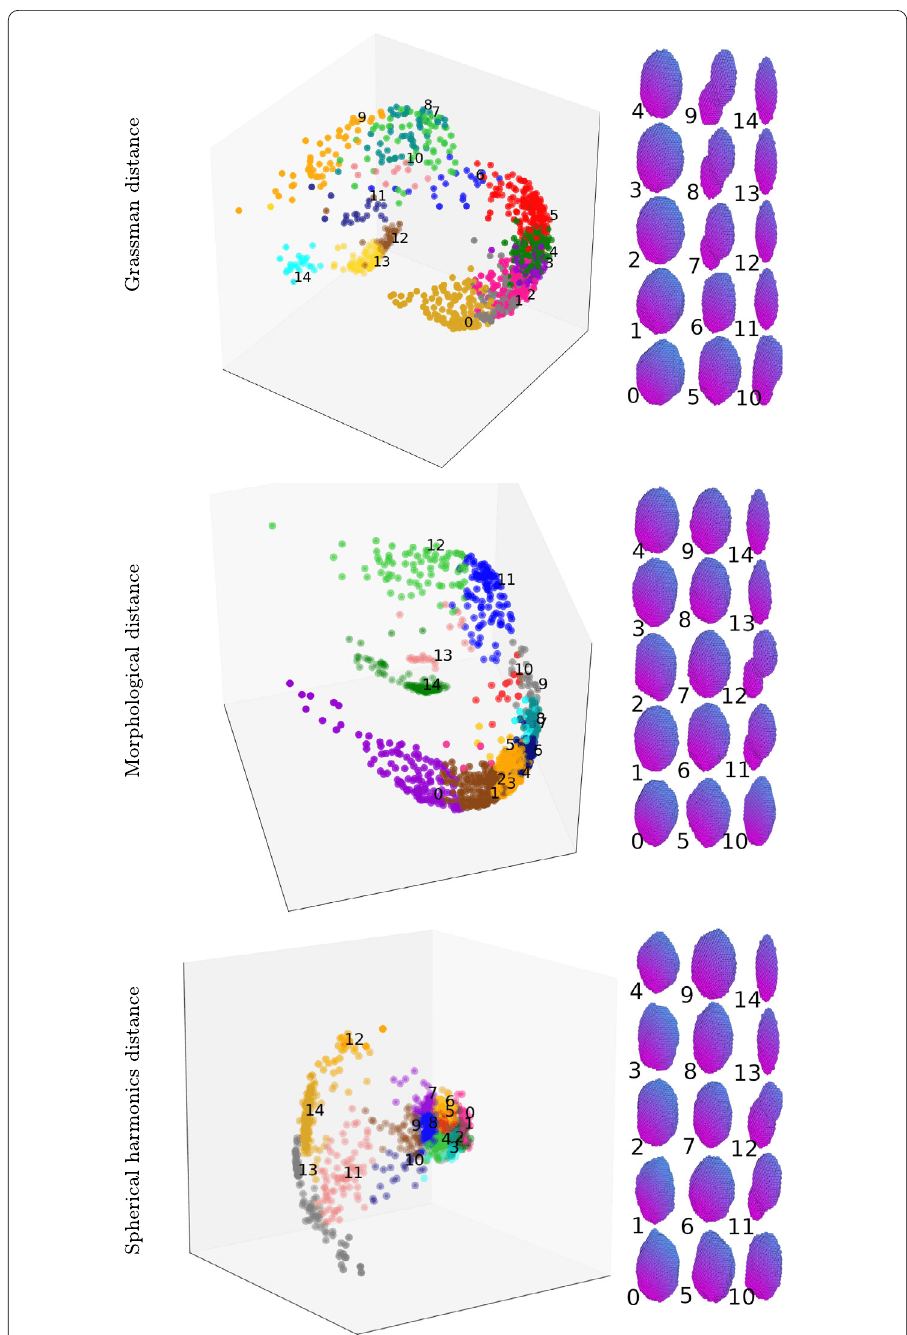
Figure 7 Clustering provided by the k -medoids algorithm using the Grassmann, morphological and spherical harmonics distances. Medoids on right